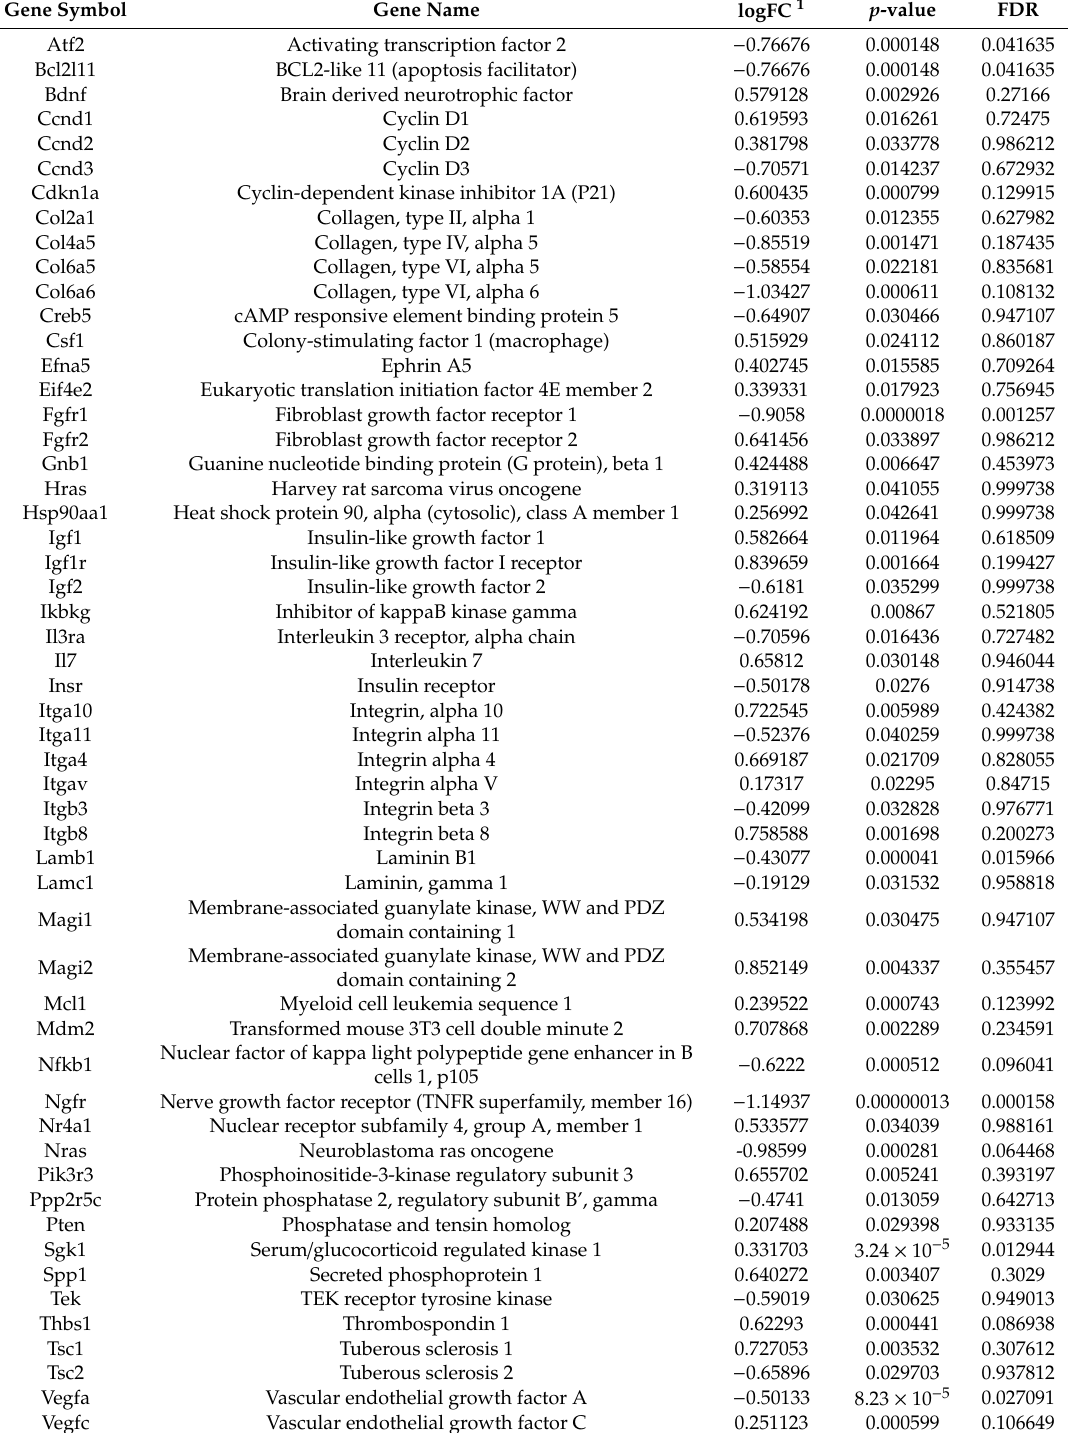
Table 1. List of PI3K-Akt signaling pathway genes with logFC, p -value, and FDR value. Gene